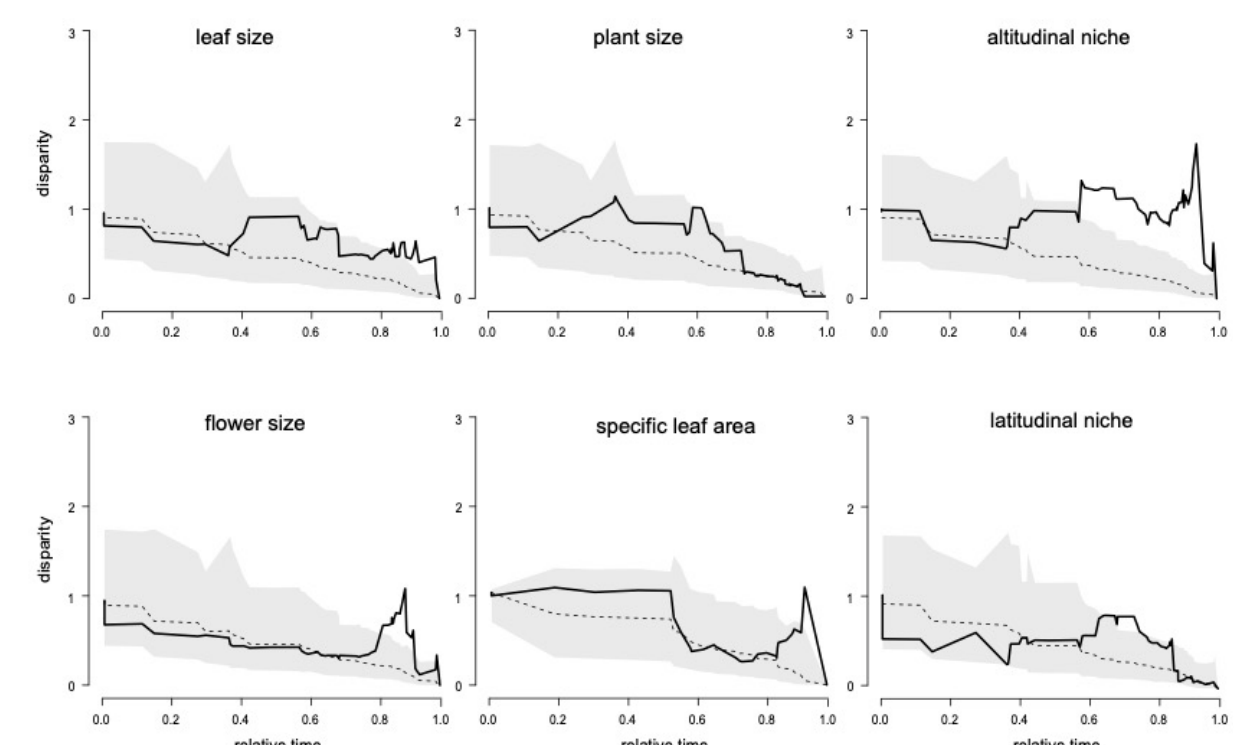
Figure 3. Mean subclade disparity through time (DTT) for the 6 traits investigated in this study (solid line), based on the maximum clade credibility (MCC) tree of the Andean species of Macrocarpaea . The dashed lines indicate the median subclade DTT based on 2000 simulations of character evolution under a Brownian motion of evolution. The gray shaded areas indicate the 95% DTT range for the simulated data. The x ‐ axis is the relative time, with x = 0 being the root of the tree and x = 1 the tips.